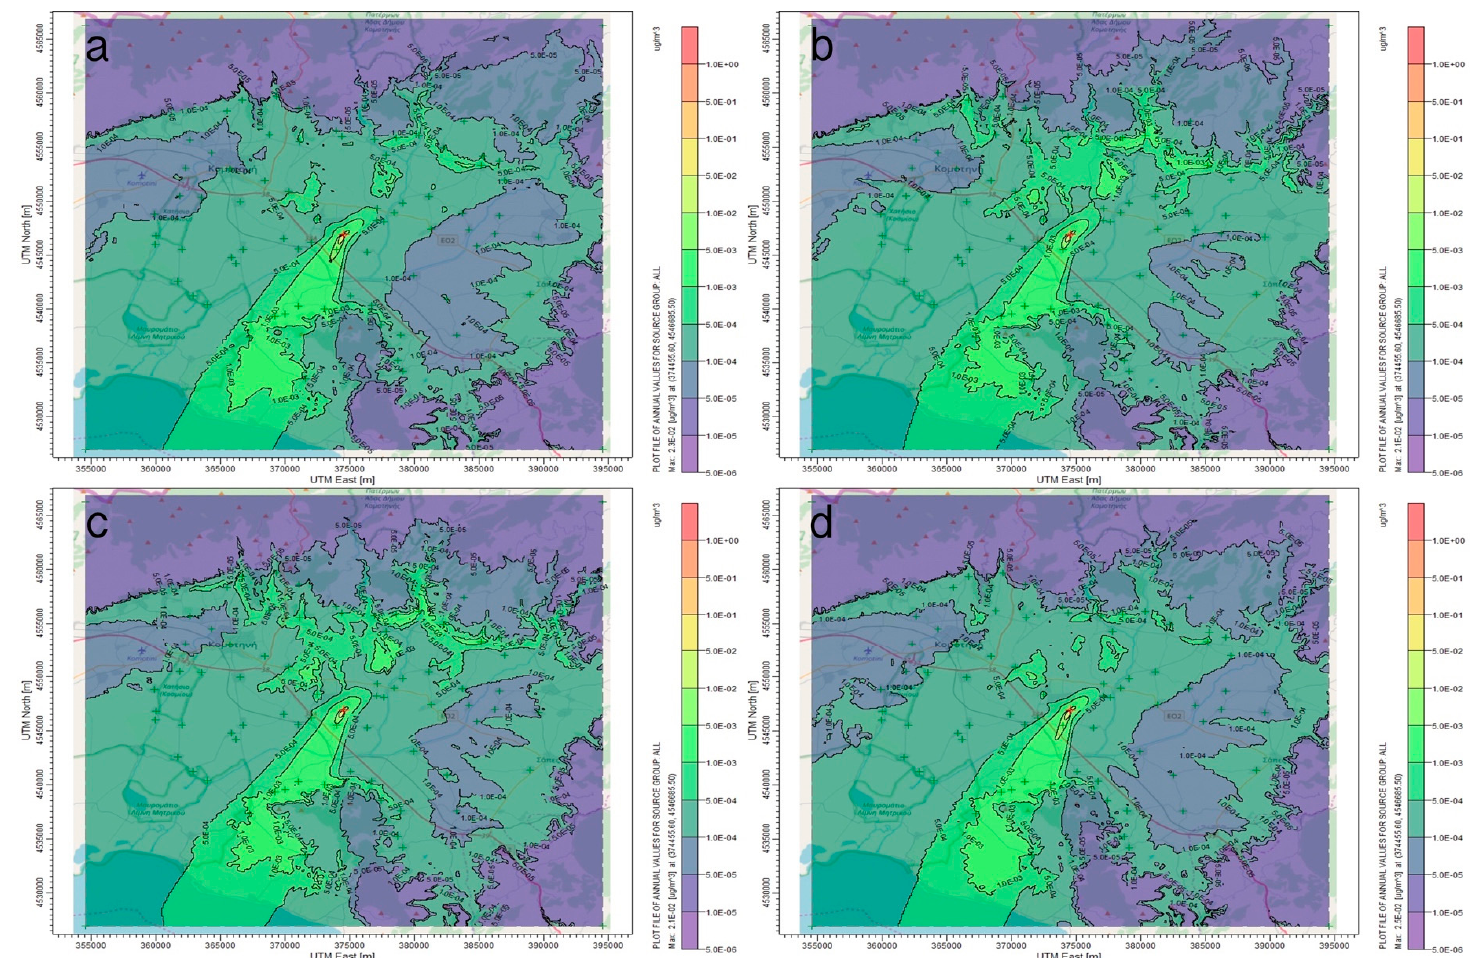
Figure 3. Annual average concentration of TSP of Pb ( µ g m − 3 ) for ( a ) the legal limit operating conditions for 2015, ( b ) the legal limit operating conditions for 2016, ( c ) the legal limit operating conditions for 2017, and ( d ) the legal limit operating conditions for 2018.